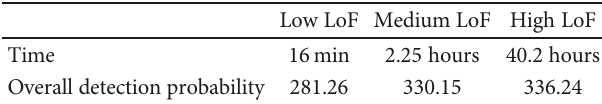
Table 7: Calculation test of